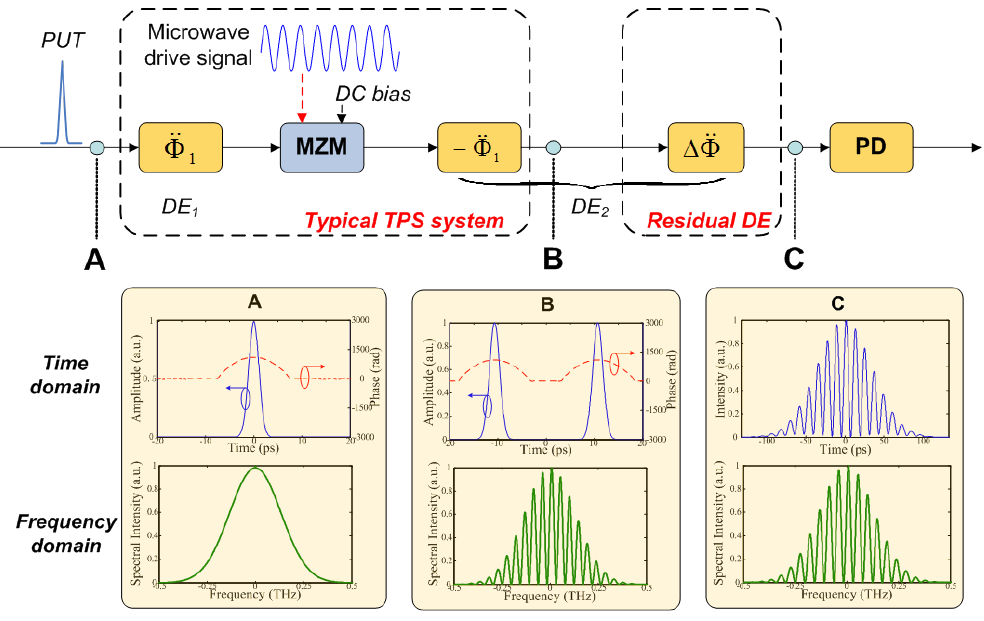
Figure 4. An alternative real-time spectral interferometry system for complete pulse characterization based on unbalanced temporal pulse shaping (UB-TPS). PUT: pulse under test, DE: dispersive element, PD: photodetector.